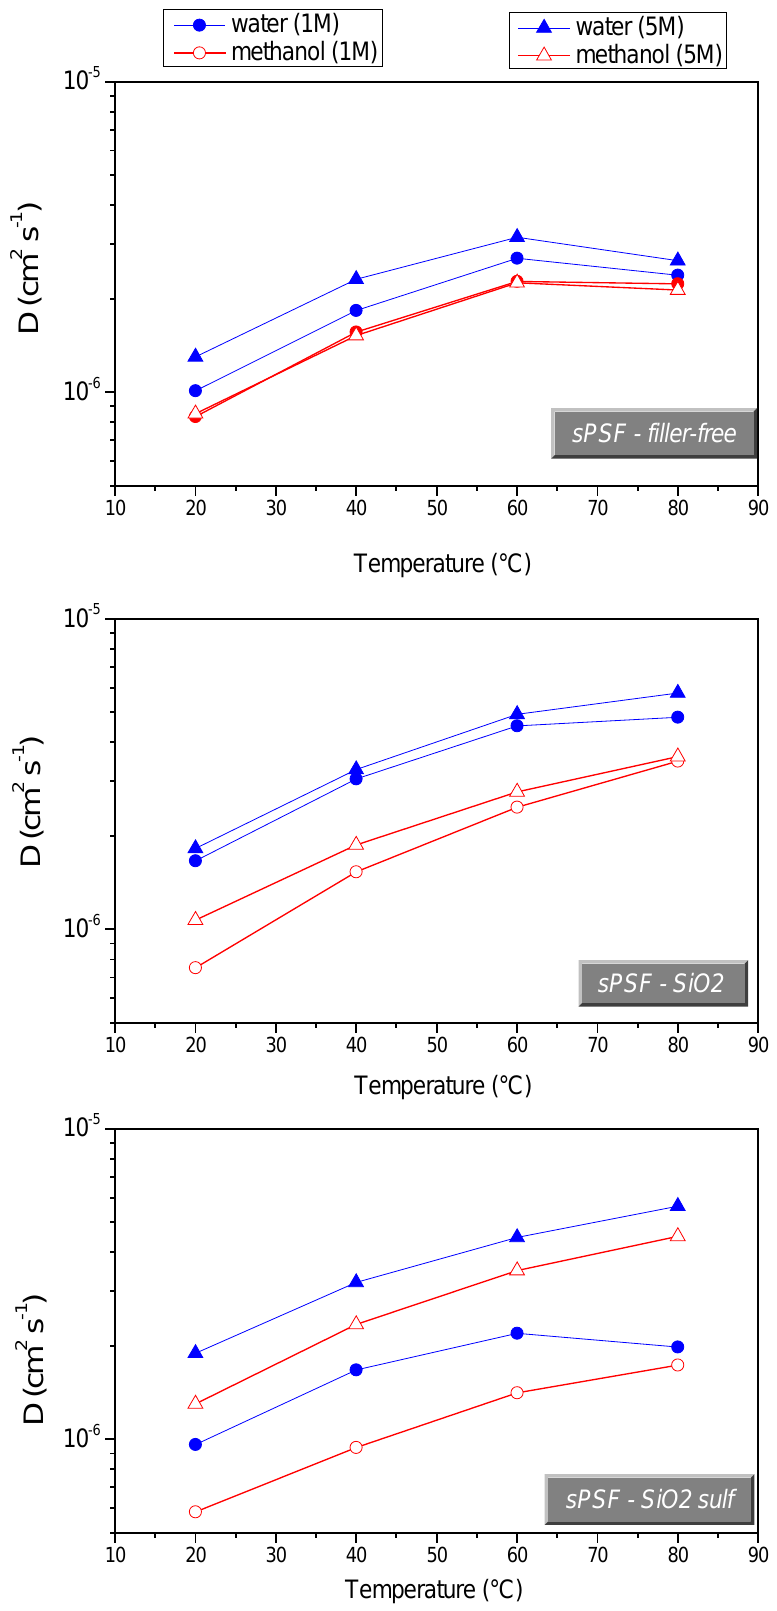
Figure 3. Self-diffusion coefficients of water and methanol in 1 and 5 M solutions confined in filler-free sPSf and the two composites, from 20 up to 80 °C.